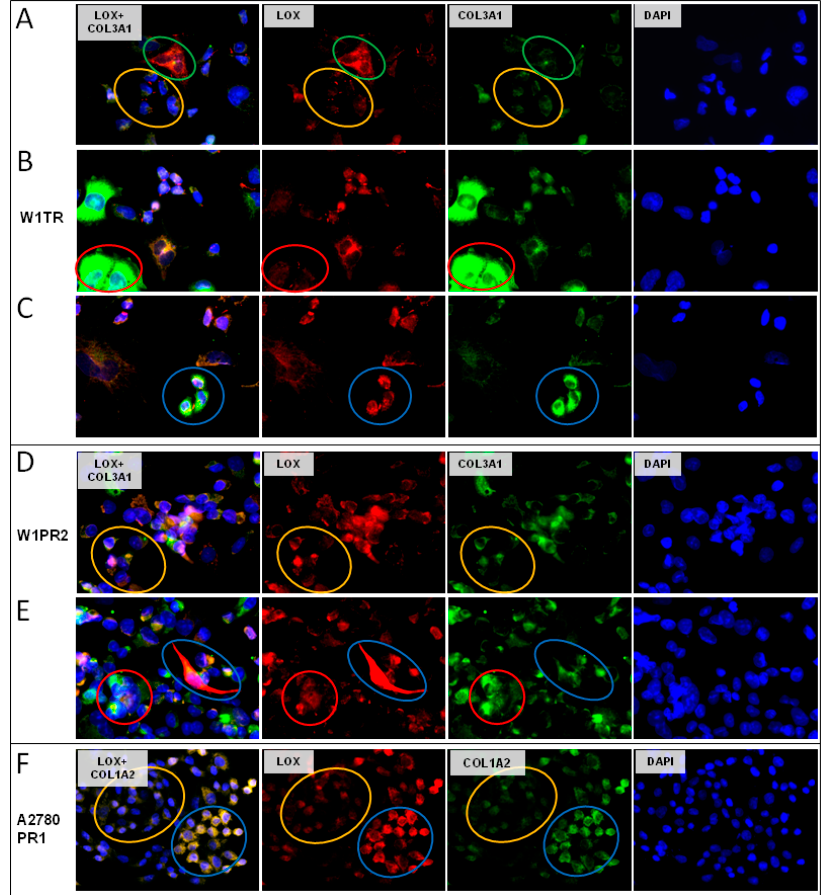
Figure 6. Immunofluorescence visualization of LOX and COL3A1 coexpression: ( A ) W1TR—low LOX/low COL3A1, yellow circle and high LOX/low COL3A1, green circle; ( B ) W1TR—low LOX/high COL3A1, red circle; ( C ) W1TR—high LOX/high COL3A1, blue circle; ( D ) W1PR2—low LOX/low COL3A1, yellow circle; ( E ) W1PR2—low LOX/high COL3A1, red circle; ( F ) A2780PR1—low LOX/low COL1A2, yellow circle and high LOX/high COL1A2, blue circle. LOX was detected using the anti-LOX antibody and Alexa Fluor ® 594-conjugated secondary antibody (red). COL3A1 was detected using anti-COL3A1 antibody and Alexa Fluor ® 488-conjugated secondary antibody (green). To visualize